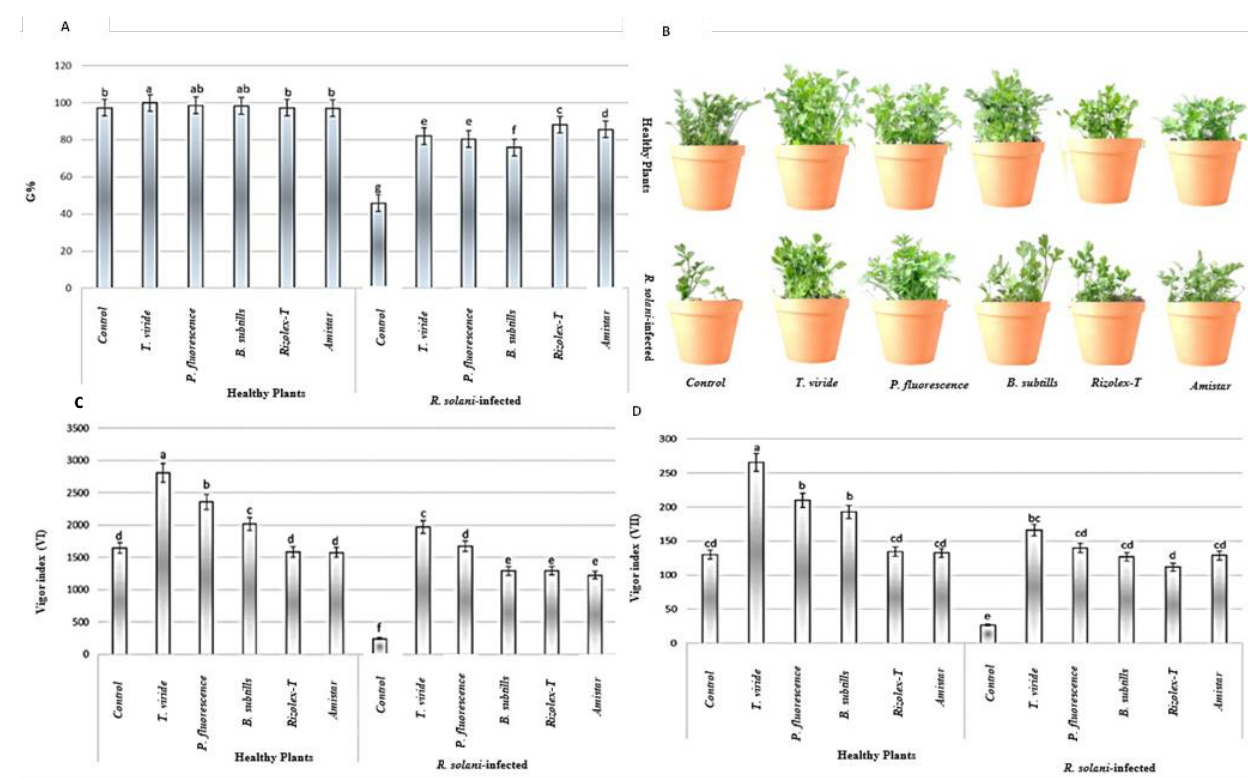
Figure 4. Effects of bioagent treatments on ( A ) the percentage of seed germination, ( B ) damping-off and viability of coriander seedlings, ( C ) the vigor index based on the root and shoot length (VI), ( D ) the vigor index based on seedling fresh and dry weights (VII). Values presented as the means ± the standard deviation of five replicates. The different letters indicate a statistically significant difference between treatments.